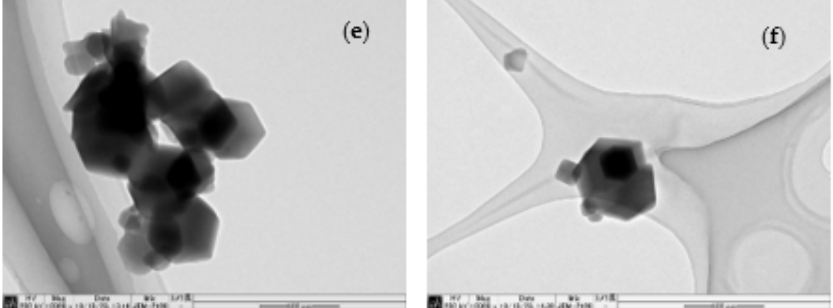
Figure A4. TEM micrographs (10k × magnification) of ( a ) pristine ZIF-8; ( b ) [EMIM][DCA]@ZIF- 8(low); ( c ) [EMIM[TCM]@ZIF-8(low); ( d ) [EMIM][TCM]@ZIF-8(high); ( e ) [EMIM][Tf 2 N]@ZIF-8(low); and ( f ) [EMIM][Tf 2 N]@ZIF-8(high).